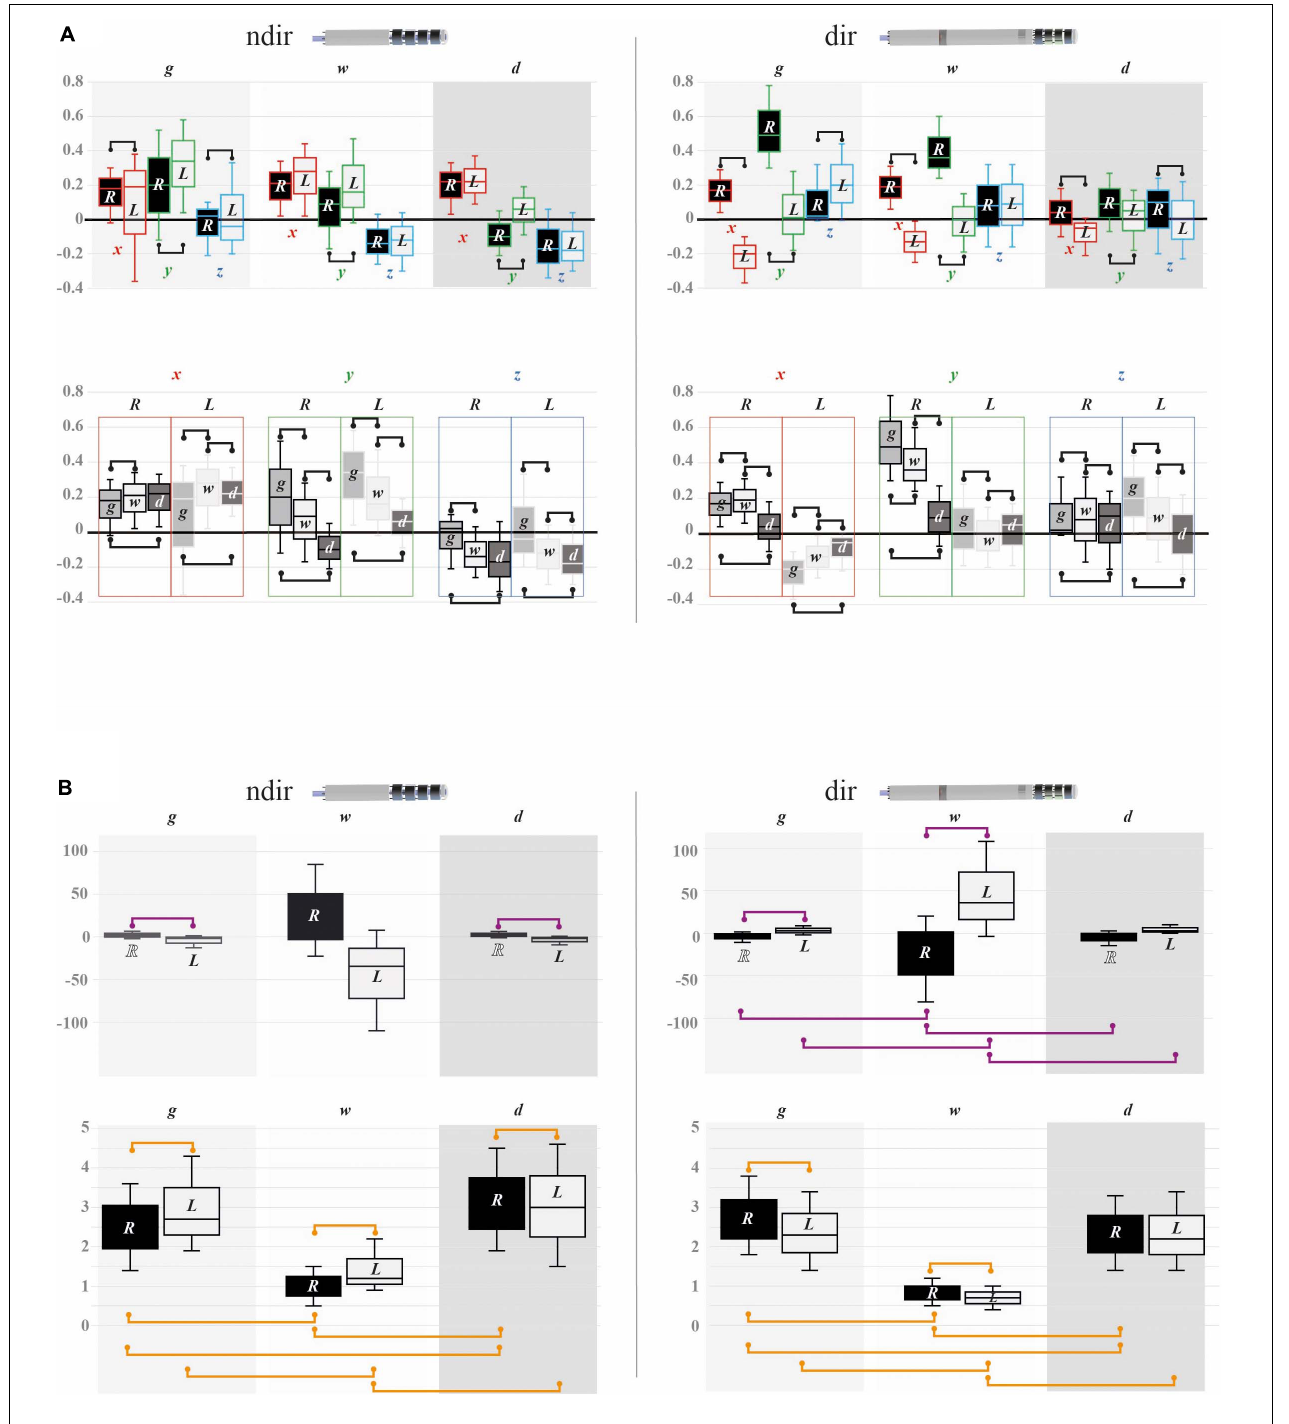
FIGURE 10 | Deformation parameters. Values of the deformation parameters of the curves of non-directional (ndir = 30) and directional (dir = 30) electrodes (15 per hemisphere): box plot; median value = central line; median interquartile range, IRQ25–IRQ75 = extremities of the segment; the significant differences are represented by handles (random-effect model, p < 0.05; see Supplementary Table 1 for values). (A) x (red), y (green), and z (blue) deformation values (–0.4 to 0.8 mm) according to the three tissue layers (gyration, g; white matter stem, w; deep brain, d) of the right (R) and left (L) hemispheres; by hemisphere within each tissue layer, top row; by tissue layer within the right and left hemispheres, bottom row. (B) Torsion (top row; –100 to 100 mm − 1 ; × 10 − 3 ) and curvature (bottom row; 0 to 5 mm − 1 ; × 10 − 2 ) values by hemisphere (R, L) according to the three tissue layers (g, w, d): interhemispheric differences, superior handles; inter-tissue-layer differences, inferior handles; purple handles, torsion, and orange handles,